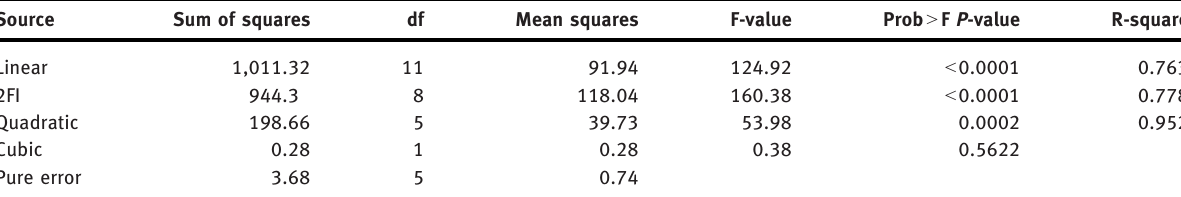
Table 5: Statistical parameters for sequential models.